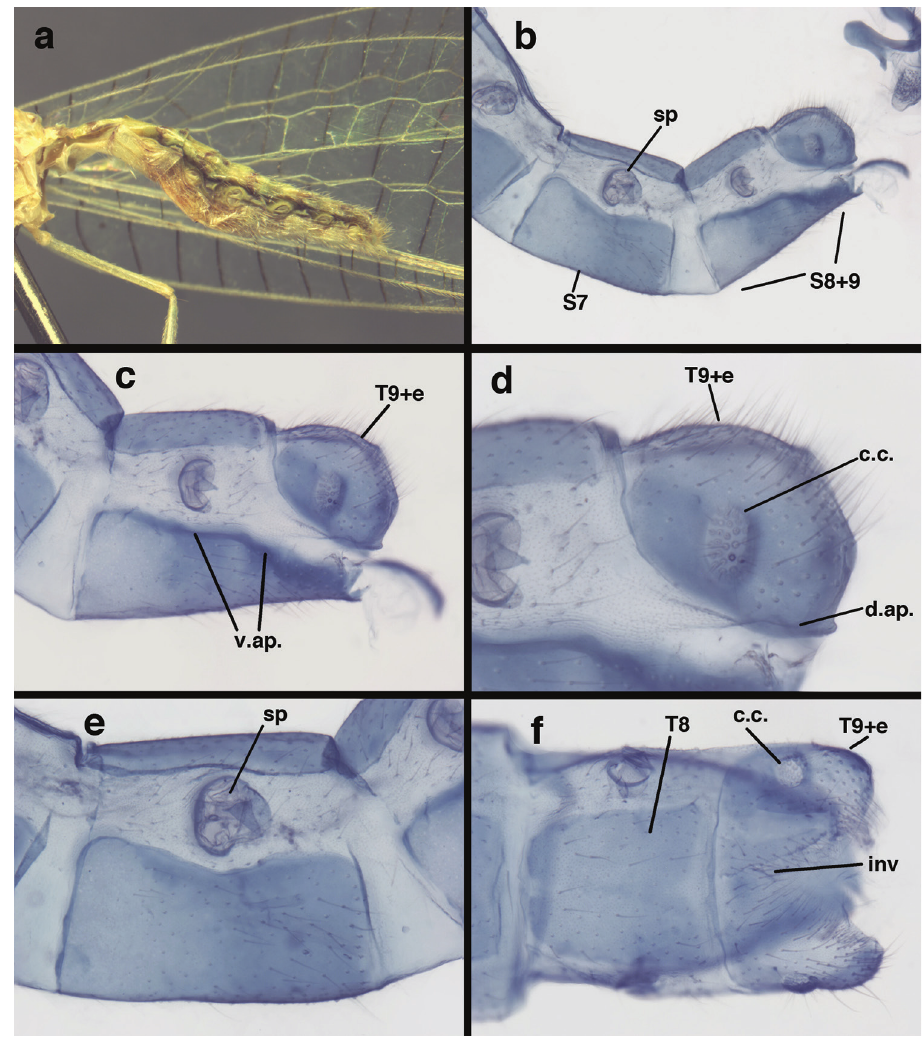
Figure 46. Ungla grandispiracula Tauber, sp. n. Male abdomen, ( a ) exterior, lateral ( b ) segments A7- terminus, lateral ( c ) terminal segments, lateral ( d ) tergite 9+ectoproct, lateral ( e ) seventh segment, lateral, with enlarged spiracle ( f ) tergite 9+ectoproct, dorsal. c.c. callus cerci d.ap. dorsal apodeme inv dorsal invagination of T9+ectoproct sp spiracle S7 seventh sternite S8+9 fused eighth and ninth sternites T8 eighth tergite T9+e ninth tergite + ectoproct v.ap. ventral apodeme ( a Colombia, Antioquia, holo- type, USNM; b–f Colombia, Valle del Cauca, paratype, FSCA).